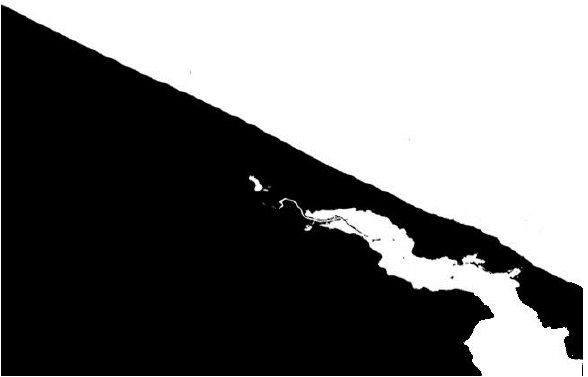
Figure 3. The segmentation results of LANDSAT-8.